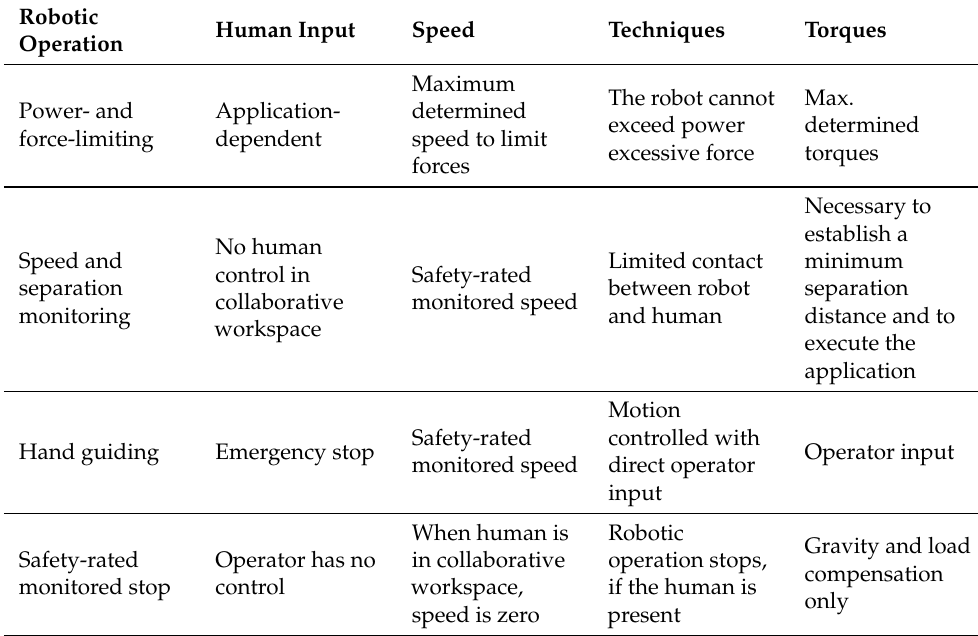
Table 1. Type of collaborative robotic operations.